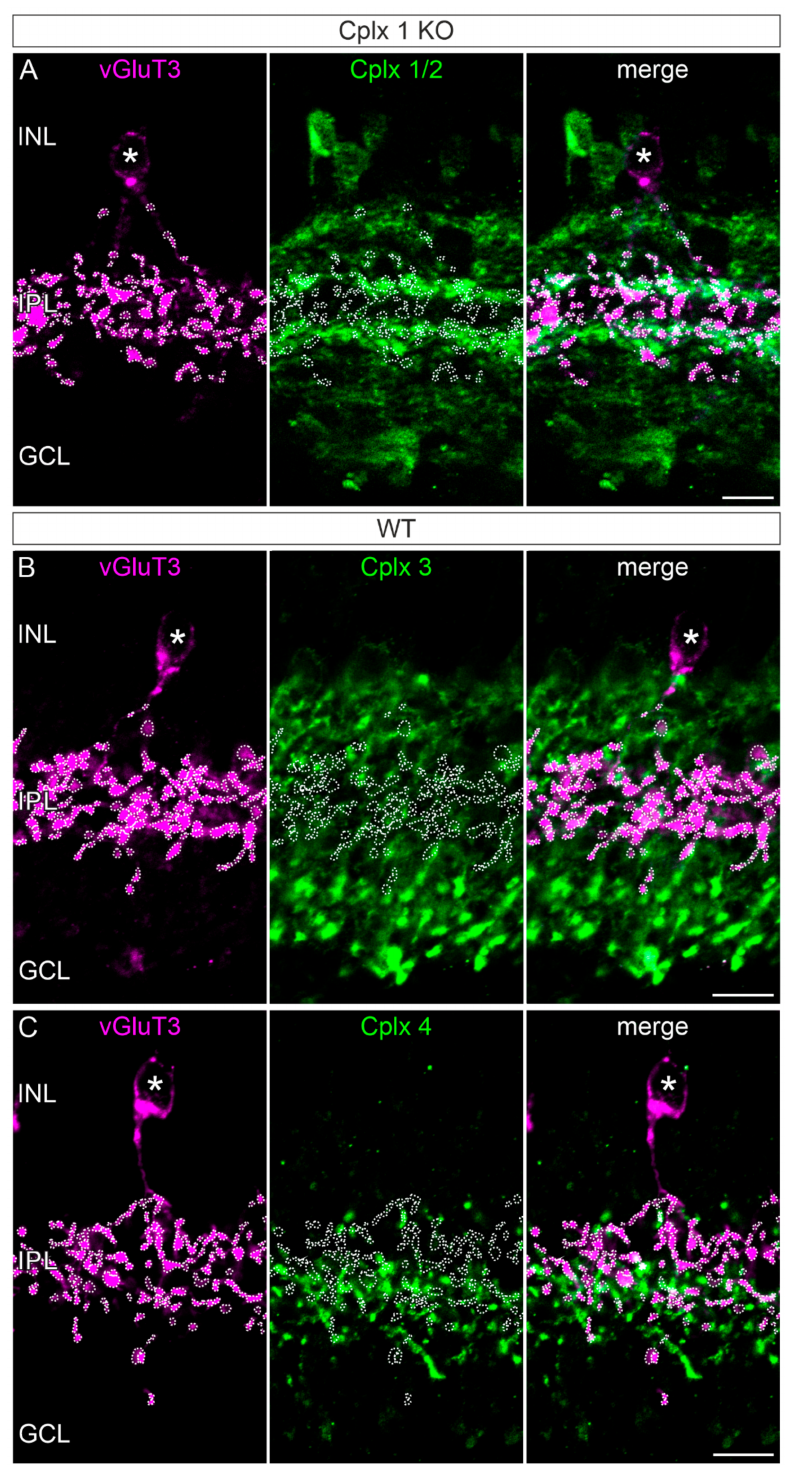
Figure 7. Absence of Cplxs 2 to 4 from vGluT3 amacrine cells in mouse retinae. Fluorescence micrographs of vertical cryostat sections through retinae of Cplx 1 knockout (KO) and wildtype (WT) mice double labeled with antibodies against the vGluT3 (glutamatergic amacrine cells) and ( A ) Cplx 1/2, ( B ) Cplx 3 and ( C ) Cplx 4. The white asterisks mark vGluT3 amacrine cell somata in the inner nuclear layer (INL); the white dotted lines outline the vGluT3 terminals. IPL, inner plexiform layer; GCL, ganglion cell layer. Scale bars = 10 µ